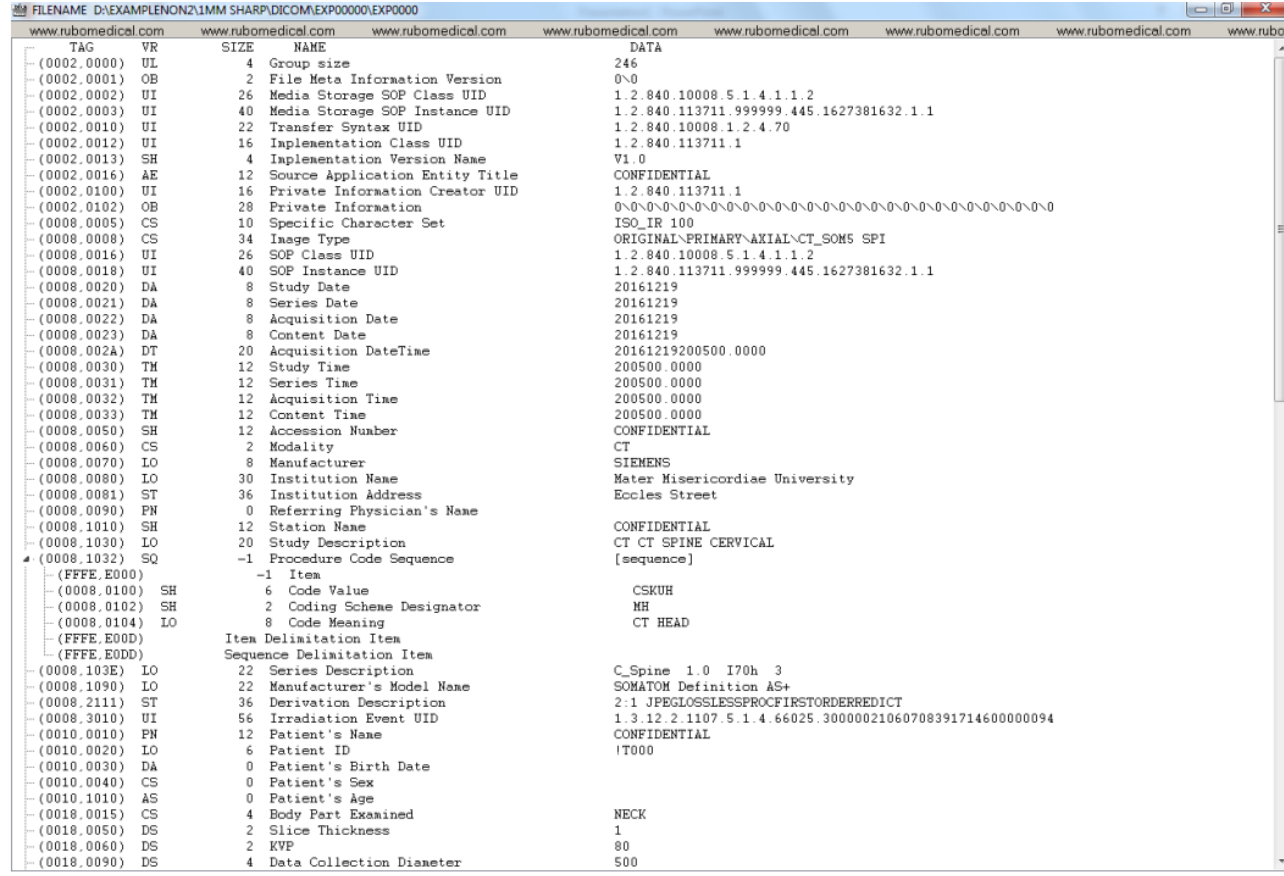
Figure A5. De-identified DICOM header data (part